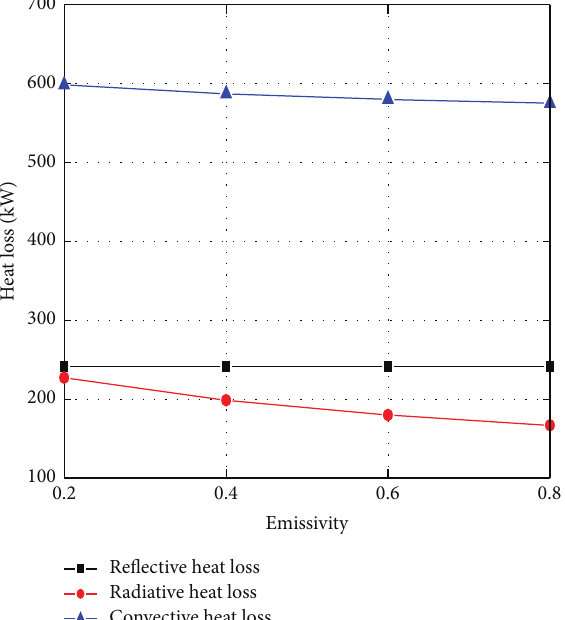
Figure 8: Three kinds of heat loss of the receiver.